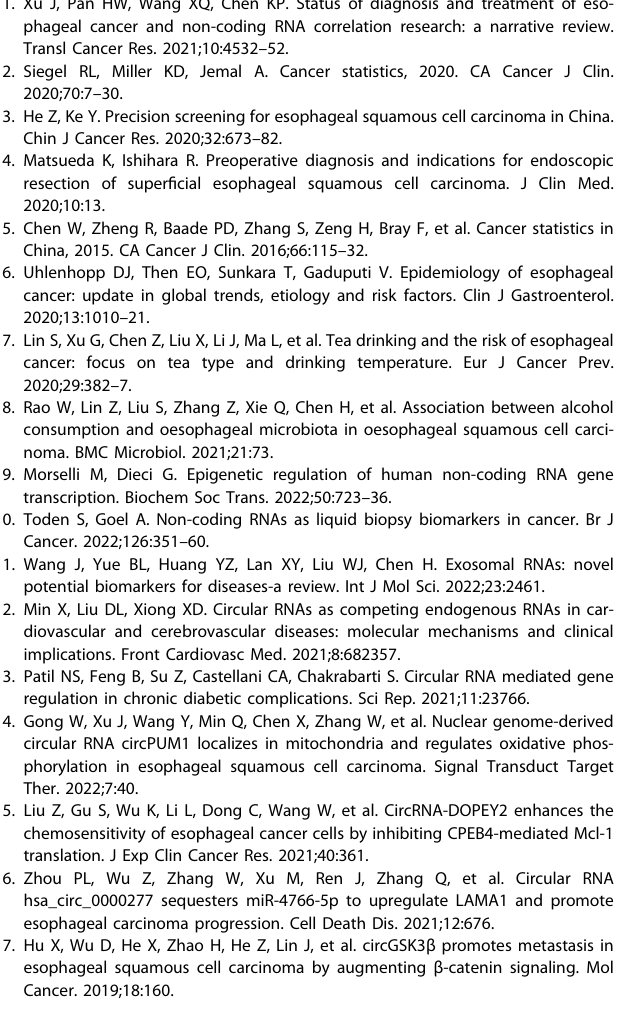
Fig. 9 Circ-CD44 promotes ESCC progression by targeting miR-23b- 5p to activate the TAB1/NF κ B